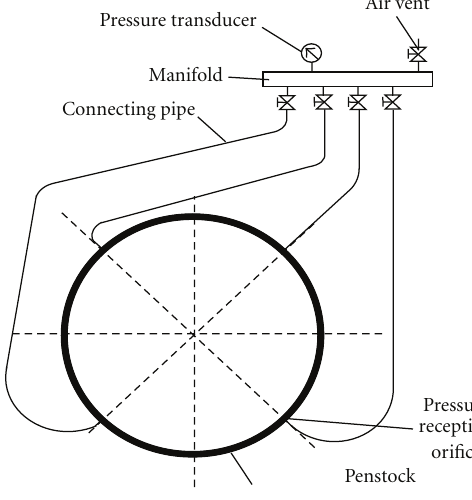
Figure 2: Scheme of sensing